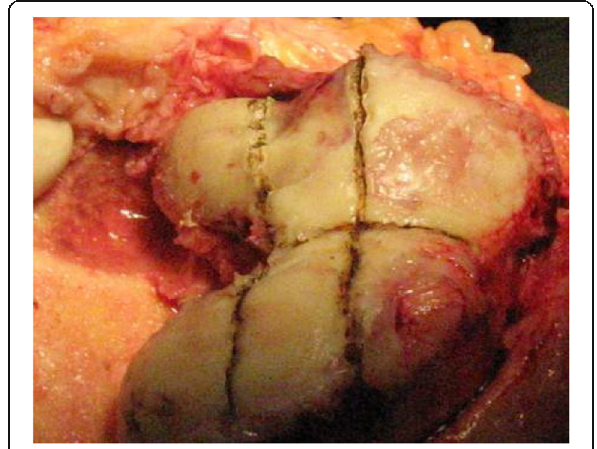
Fig. 2 The epicondylar axis and the Whiteside line were also determined and used as a control for bone resection